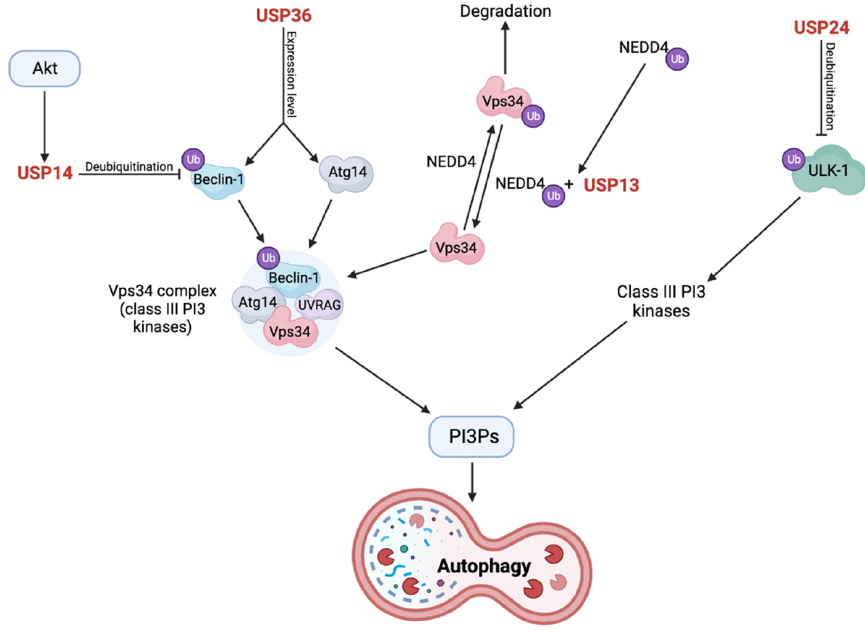
Figure 6. Visualization of how USP13, USP14, USP24, and USP36 affect the regulation of autophagy through PI3Ps. USP14 is activated by Akt-mediated phosphorylation, which results in USP14-mediated deubiquitination of Beclin-1. Beclin-1 in its ubiquitinated form interacts with Atg14 and UVRAG in the Vps34 complex, which is a class III PI3 kinase that produces PI3P from PI. PI3Ps in turn aid in autophagy by mediating autophagosome formation. USP14 hereby acts as a negative regulator of autophagy. USP36 increases the expression level of Beclin-1 and Atg14, leading to increased autophagy through the formation of the Vps34 complex and formation of PI3Ps. USP13 forms a complex with NEDD4, which can deubiquitinate Vps34 and increase the formation of the Vps34 complex, inducing autophagy through the formation of PI3Ps. Lastly, USP24 inhibits autophagy by deubiquitinating ULK-1, which positively regulates other class III PI3 kinases and aids in the autophagy process. USP24 is hereby a negative regulator of autophagy, although its association to PD is still somewhat controversial. Created using www.BioRender.com (accessed on 15 December